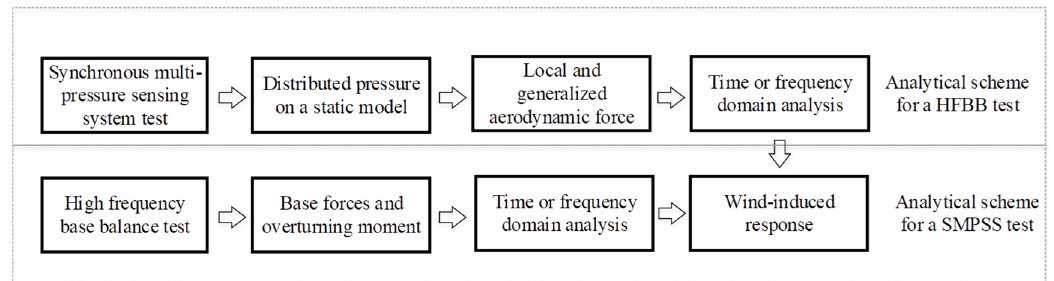
Figure 19. Analytical scheme for a high frequency base balance test or static synchronous multi- pressure sensing system test.